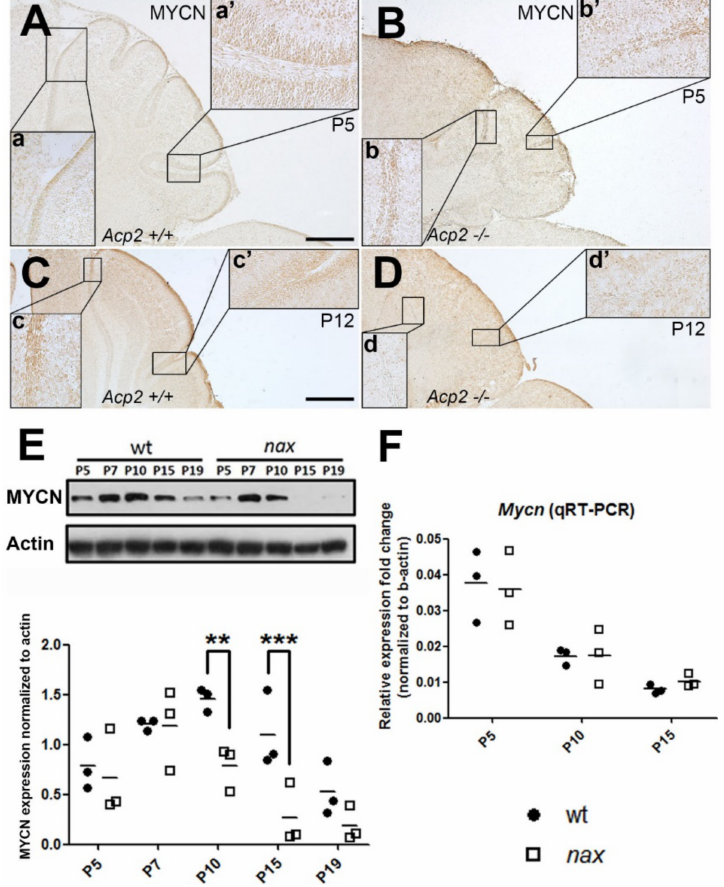
Figure 8. MYCN is expressed by GC precursors in wt and nax cerebella, but cerebellar MYCN protein levels are lower in the nax mutant mouse at P10 and P15. ( A , B ) Sagittal sections of P5 wt and nax mutant mouse cerebella immunostained with MYCN show expression in GC precursors. Higher magnifications of the wt ( A ) and nax ( B ) anterior ( a , b ) and posterior ( a’ , b’ ) lobes are shown in the inserted panels. ( C , D ) Sagittal section of P12 nax mutant mouse cerebellum ( D ) immunostained with MYCN shows lower expression in GC precursors compared with wt littermates ( C ). Higher magnifications of the wt ( C ) and nax ( D ) anterior ( c , d ) and posterior ( c’ , d’ ) lobes are shown in the inserts. ( E ) Western blot analysis of MYCN expression in wt and nax cerebellar lysates at P5, -7, -10, -15 and -19 (wt: n = 3 and nax : n = 3). In the wt samples, MYCN protein levels increased from P5 to P10 and subsided towards the end of clonal expansion (P15). In the nax cerebellum, MYCN protein expression was comparable to wt at P5, but peaked earlier at P7 and then progressively decreased. Importantly, expression was significantly lower in the nax mutant at P10 and P15. The actin shows consistent and equal loading of all cerebellar samples. The scatter plots show individual data points and statistical analysis was performed using one-way ANOVA (** p < 0.01 and *** p < 0.001). ( F ) Cerebellar Mycn mRNA expression gradually decreased at P10 and 15 as compared to P5 to a similar extent in both nax and wt mice. No significant differences in Mycn expression were observed between the groups at any time point. β -actin gene expression was used to normalize the qRT-PCR data. The data in the graph are presented as the mean ± SEM, and statistical analysis was performed using an unpaired t -test. Scale bars: 500 µ m in ( A applies to ( A , B ) and 500 µ m in ( C applies to ( C , D